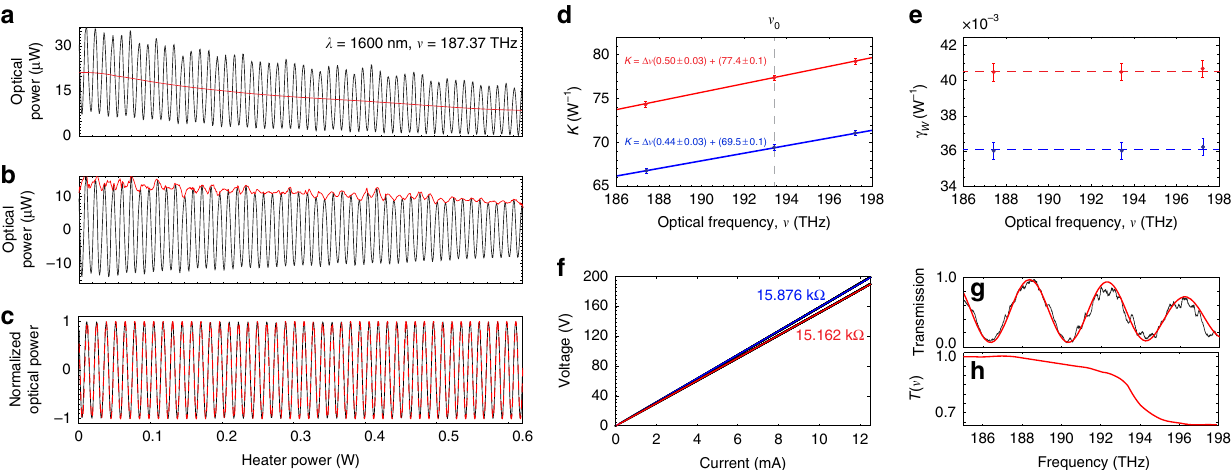
Fig. 2 Si-FTS calibration using a tunable laser source. Measurements are performed in the C-band. a – c Interferogram at 183.37 THz (1600 nm) as a function of dissipated power in heater H 2 . The mean power (red trace in a ) and the envelope (red trace in b ) are subtracted to obtain the curve in c , fi tted (dashed-red trace) using Eq. 13. The envelope in b is the absolute value of the interferogram ’ s Hilbert transform. d – f Data in blue and red are related to heaters H 1 and H 2 , respectively. d Parameter K ( ν ) obtained from the non-linear fi t, adjusted according to Eq. 14. Error bars are s.d. (95% con fi dence level). e Non-linear parameters γ W ,1 = (36.2 ± 0.3) × 10 − 3 W − 1 and γ W ,2 = (40.5 ± 0.3) × 10 − 3 W − 1 obtained from the non-linear fi t. Error bars are s.d. (95% con fi dence level). f Current vs voltage (IV) response of both heaters and calculated electric resistance. g Experimental (black trace) and calculated (red trace) transmission spectrum of the MZI at non-zero optical delay (0.172ps). The calculated transmission is obtained using Eq. 15 to extract the MZI